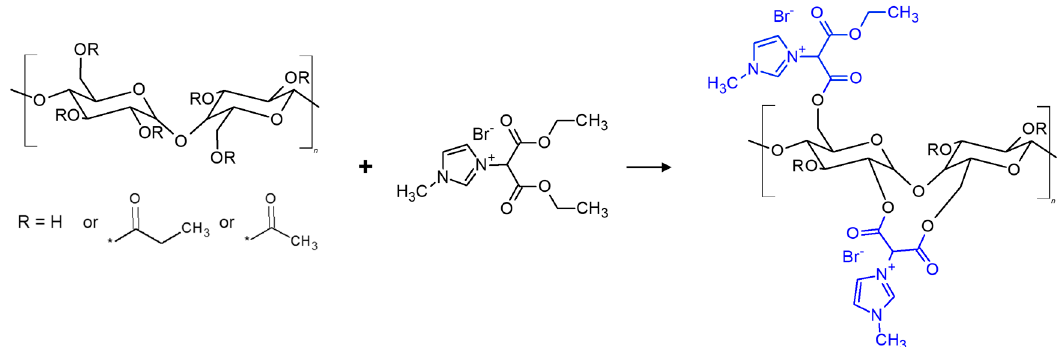
Figure 6. Scheme of the possible transesterification reaction between CAP and RIL.